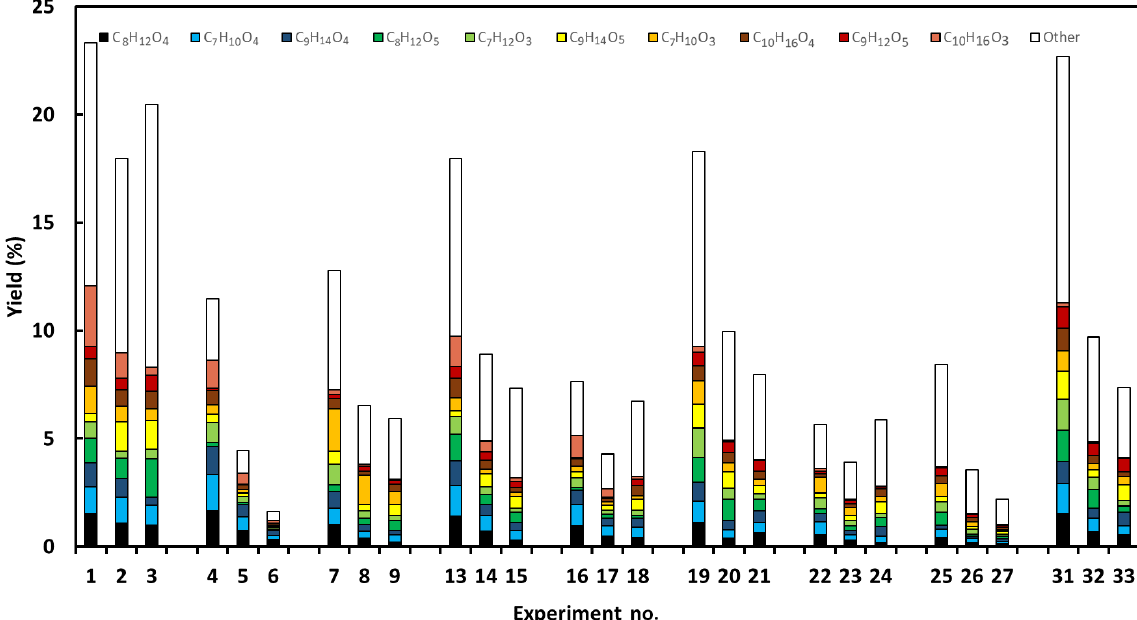
Figure 4. The molar yields of identified C 7 –C 10 acids. The most important acids (averaged over all experiments) are C 7 H 10 O 3 , C 7 H 10 O 4 , C 8 H 12 O 4 , C 8 H 12 O 5 , C 9 H 14 O 4 , C 9 H 14 O 5 , C 10 H 16 O 3 and C 10 H 16 O 4 and are illustrated using individual colours (see legend). Experi- ments 10–12 and 28–30 were removed due to uncompleted particle-phase characterisation.